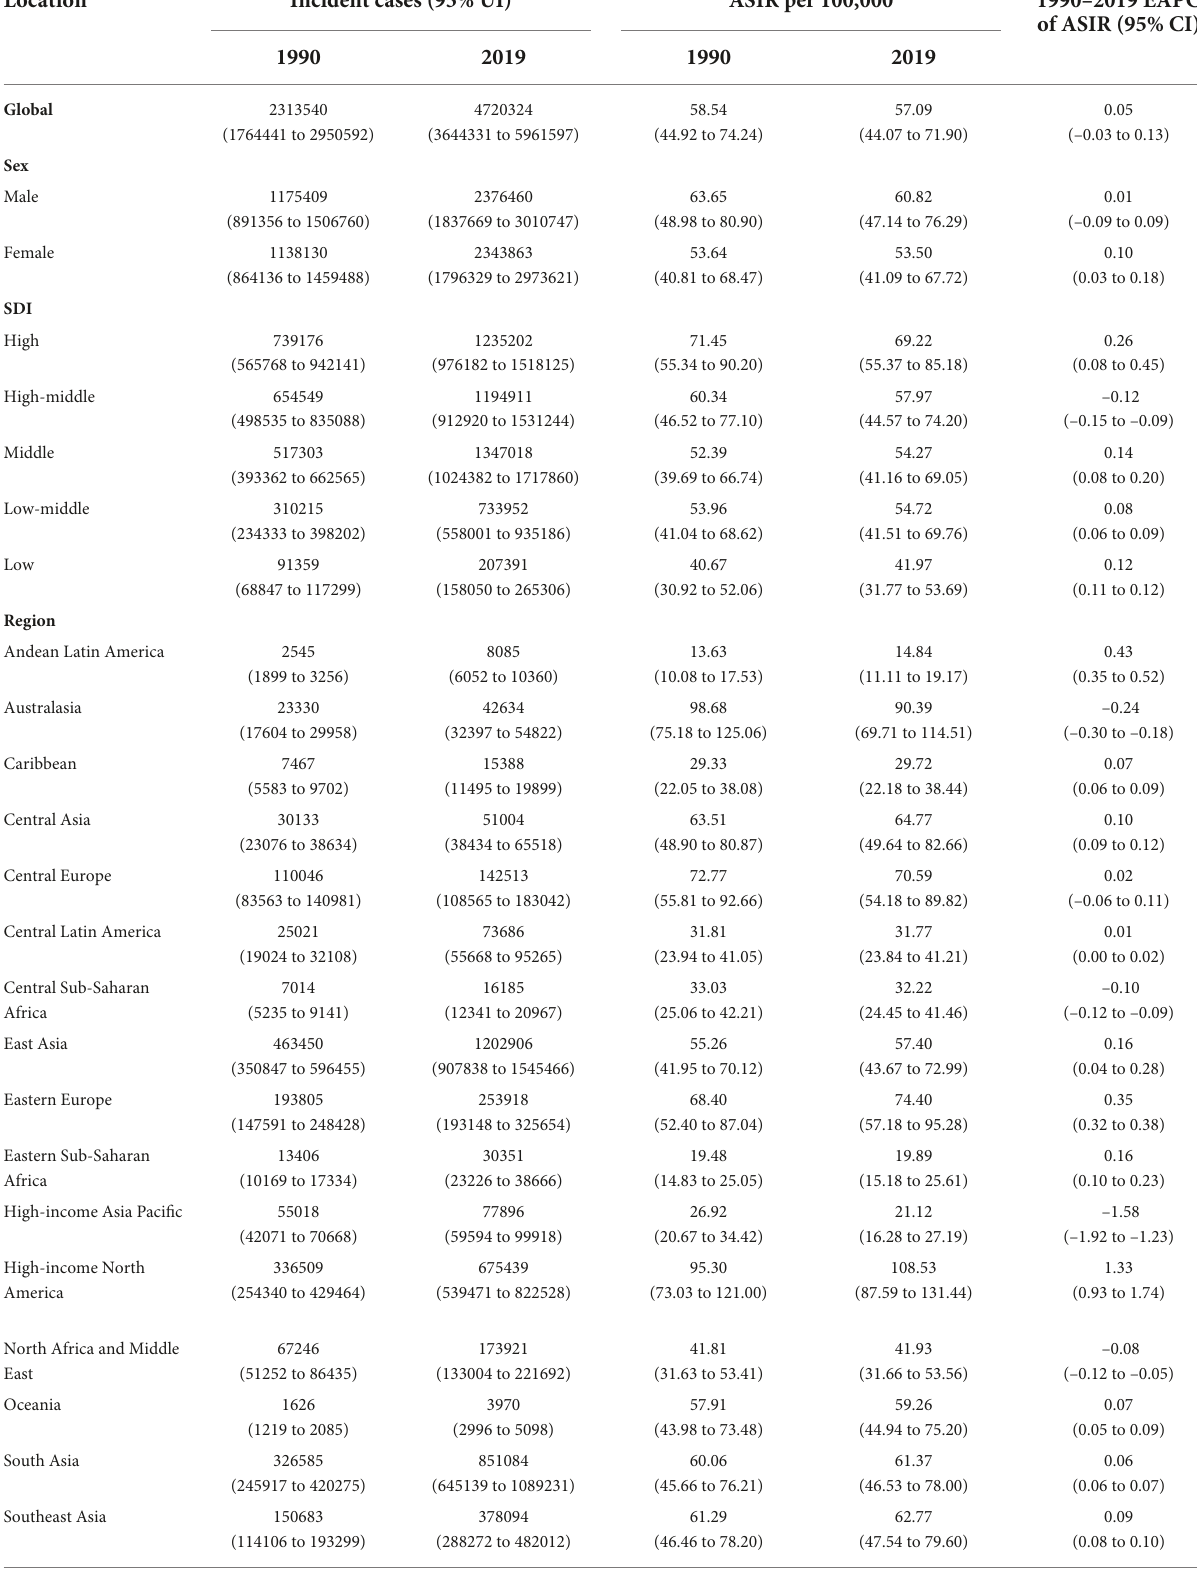
TABLE 1 The incidence of atrial fibrillation in 1990 and 2019, and its temporal trends from 1990 to